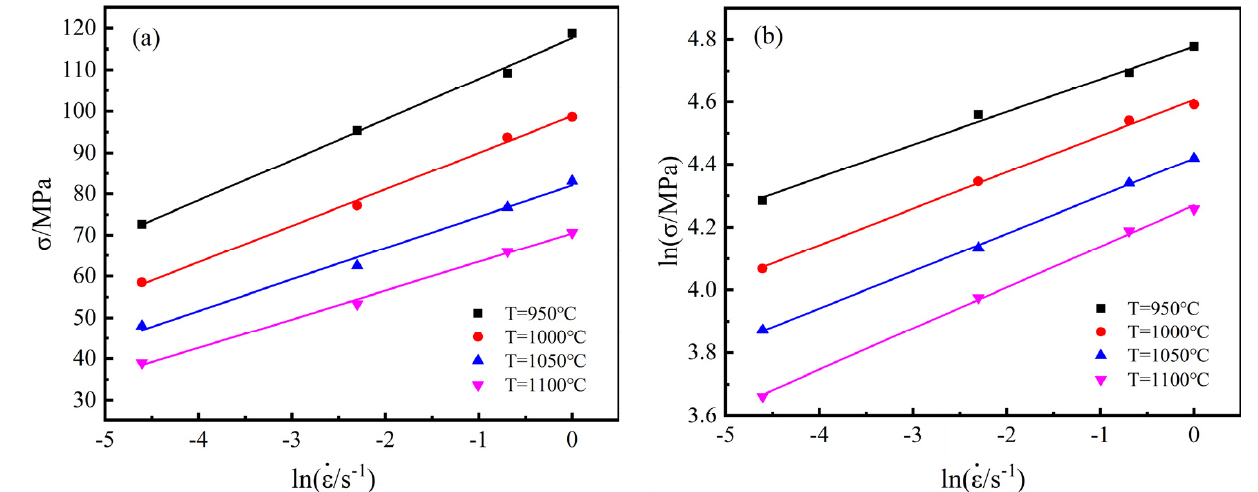
(cid:0) . (cid:1) ε vs. ln ( σ )